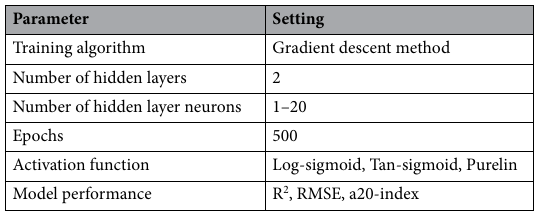
Table 6. BPNN parameter settings.